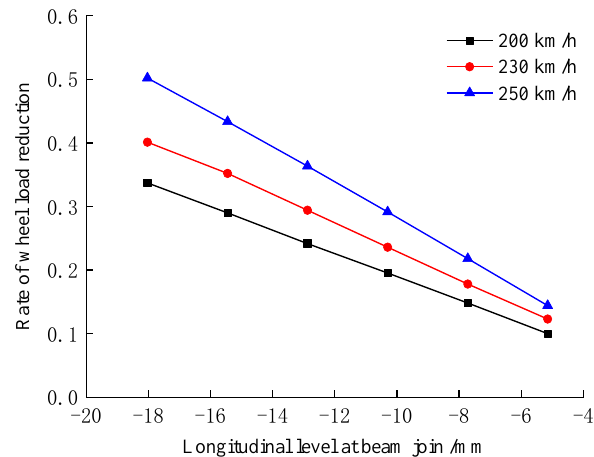
Figure 20. Rate of wheel load reduction.